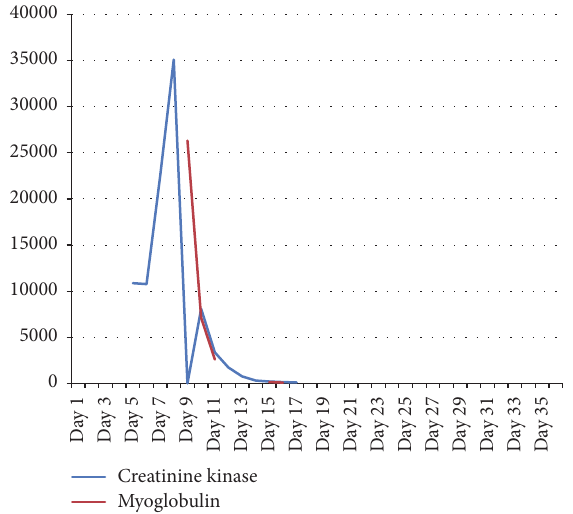
Figure 1: The graph shows the levels of creatinine kinase (CK) and myoglobulin in the 𝑦 -axis and the admission days in the 𝑥 -axis. The rapid fall and normalization of the CK and myoglobulin in our patient, after cessation of treatment with atorvastatin and fusidic acid on 6th day prior to admission, clearly suggest the diagnosis of pharmacokinetic interaction between atorvastatin and fusidic acid as cause of